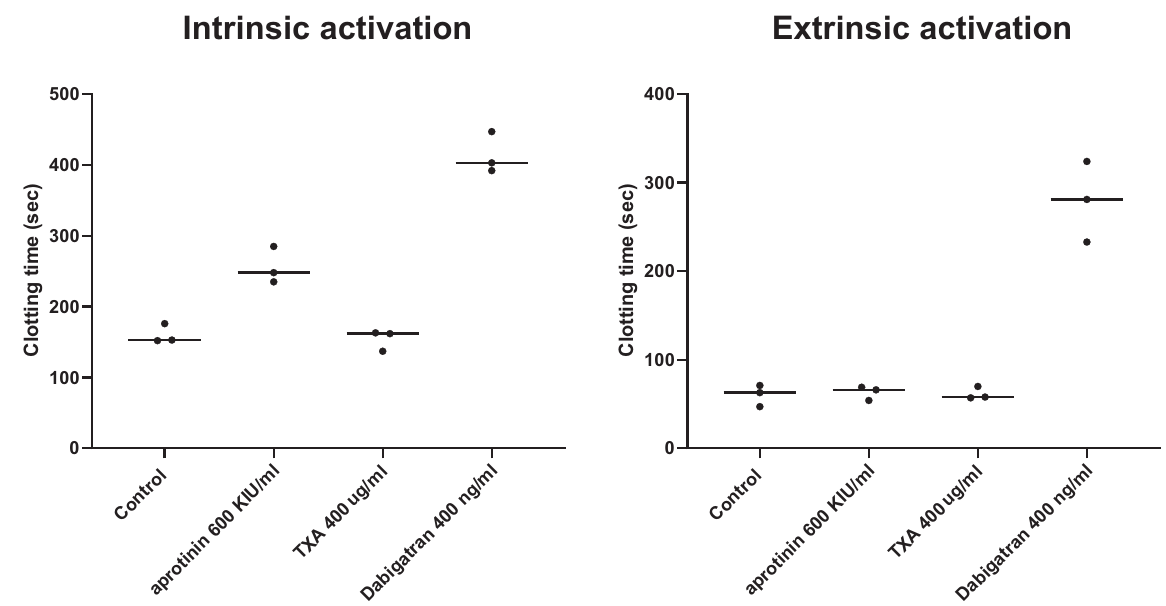
Fig. 5 Effects of aprotinin, TXA, and dabigatran on whole blood clot formation following intrinsic or extrinsic activation of coagulation. Aprotinin or TXA were added to whole blood from healthy individuals and clot formation was monitored in a ClotPro device following activation by the Ex test (panel A) or In test (panel B). Clot times of three donors are shown. Horizontal bars indicate